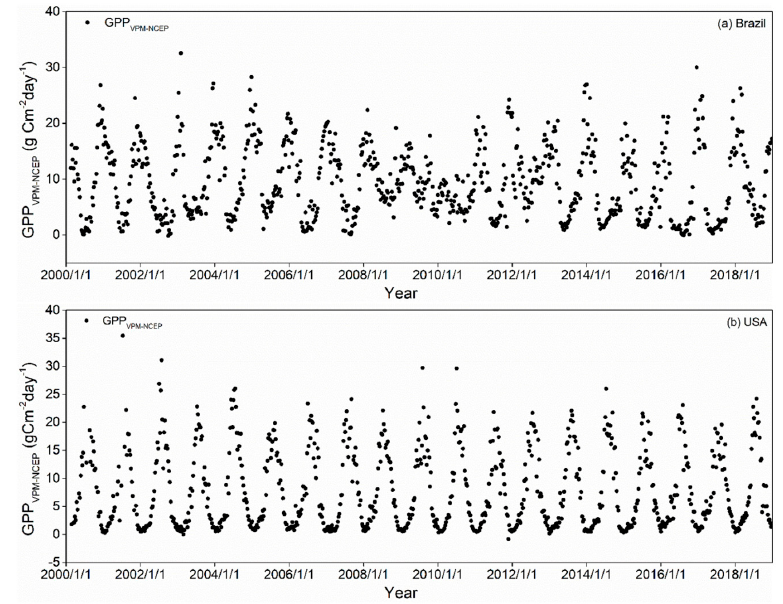
Figure Figure 8. Interannual variation in simulated daily gross primary production (GPP VPM-NCEP ) (g C m − 2 day − 1 ) from the Vegetation Photosynthesis Model (VPM) model with NCEP climate data at the two sugarcane EC tower sites during 2000–2018. ( a ) Brazil site; ( b ) Louisiana, USA site.